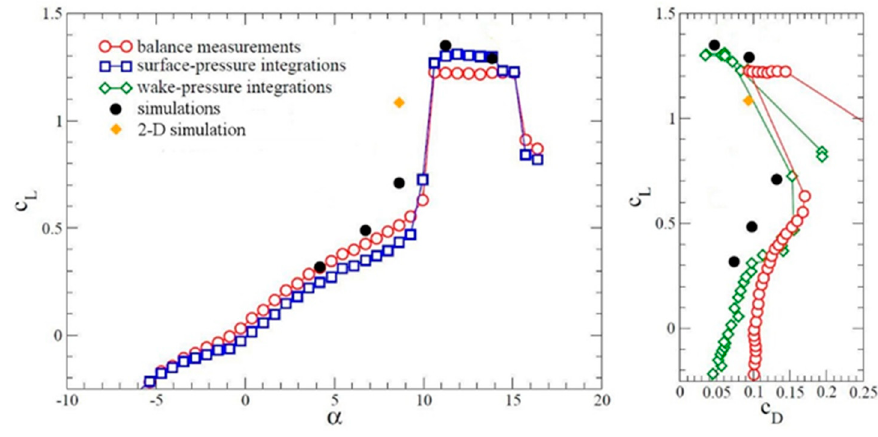
Figure 21. Lift and drag data for Re = 64,200. (Reprinted from [32]).